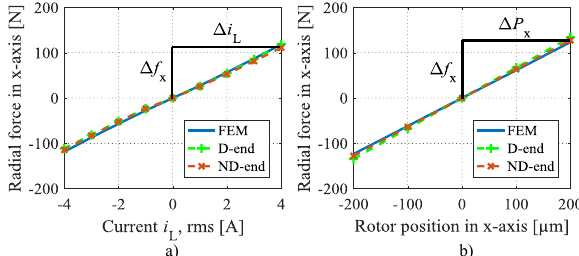
Figure 4: Cross-sectional view of the rotor in the pro- totype system. Locations of the bearingless motors and the sensor surfaces are measured respect of the center of mass.